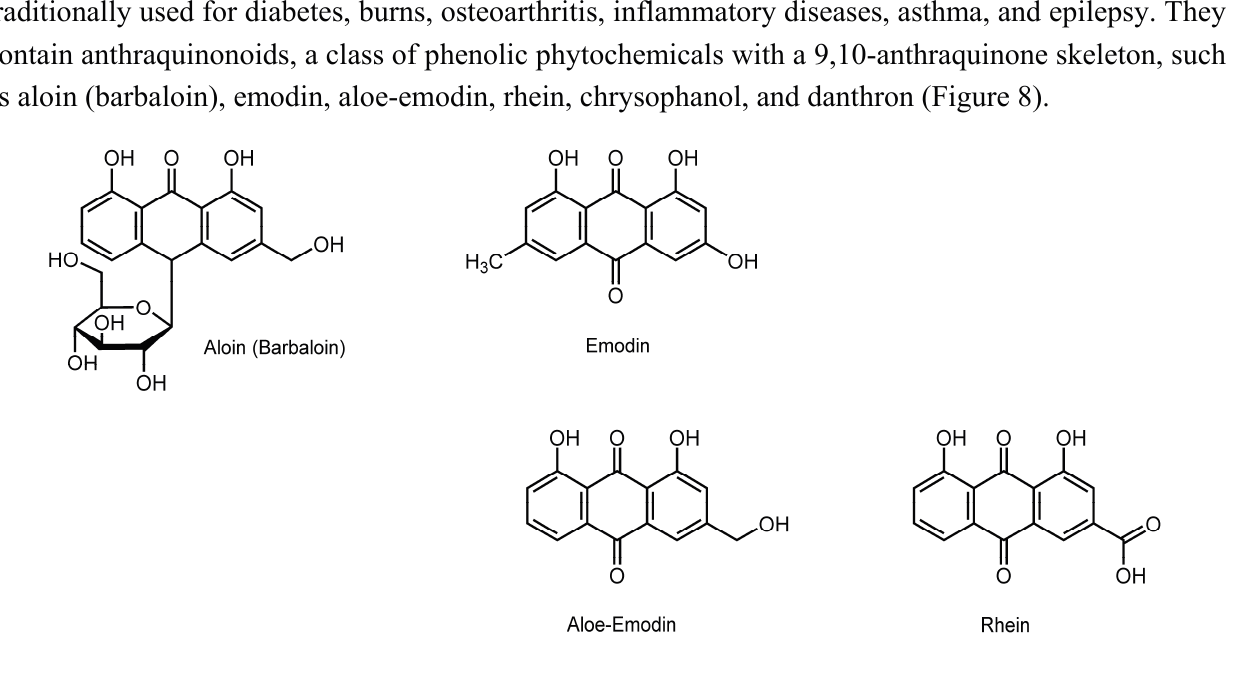
Figure 8. Structures of membrane-interactive